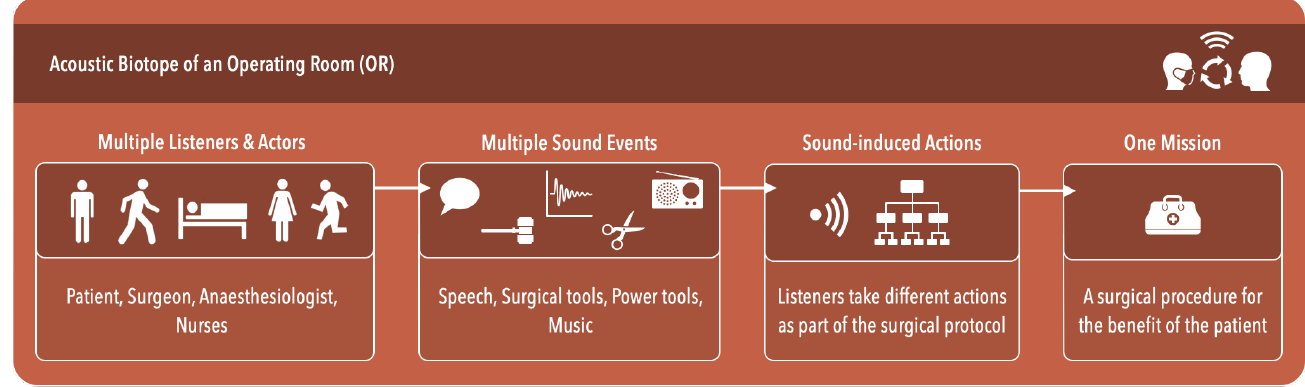
Figure 4. Basic representation of the acoustic biotope of an OR. The ultimate goal of an acoustic biotope is to facilitate sound-induced actions and interactions amongst the OR team members.